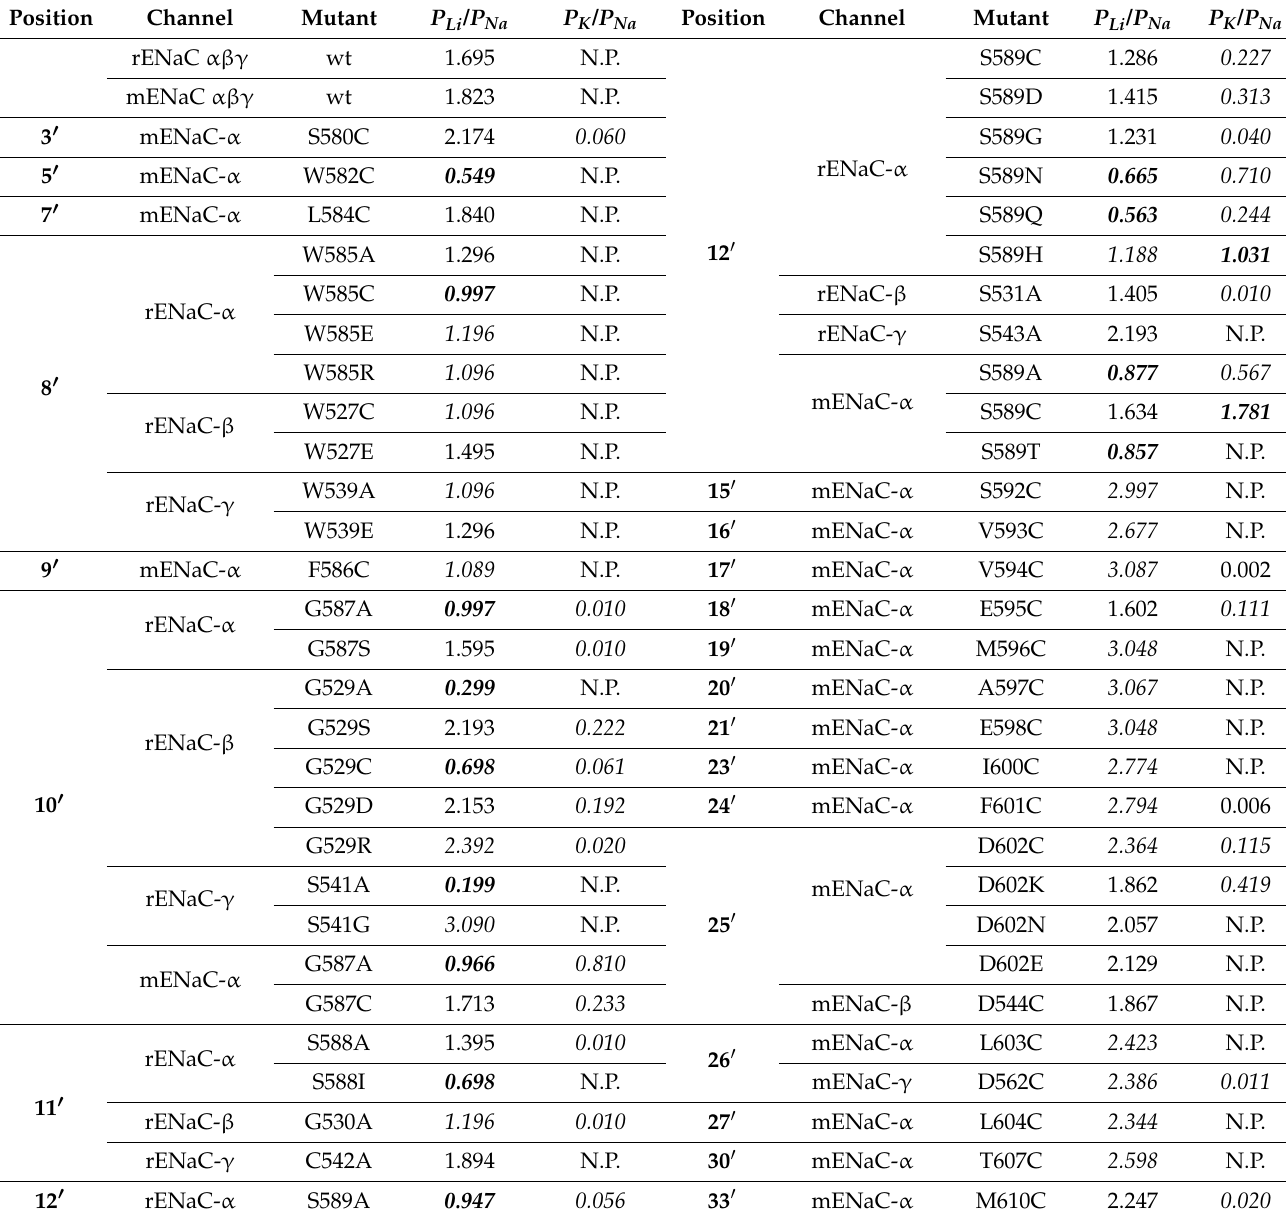
Table 3. Permeability ratios of tested ion over Na + for ENaC single mutations variants . Ratios that are different from wild type by ± 30% are represented in italics (considerate as “significant”); and ratios that describe change in ion selectivity are represented in